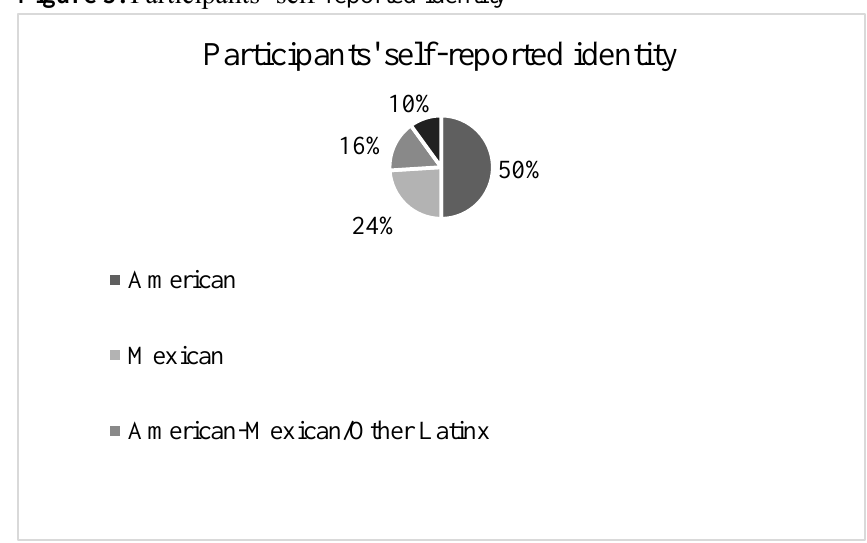
Figure 3. Participants’ self-reported identity